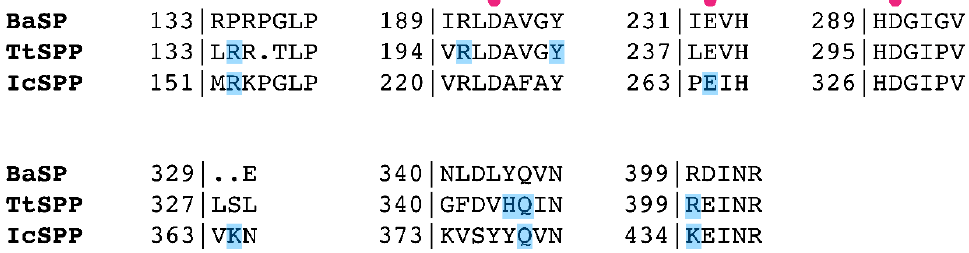
Figure 4. Partial multiple sequence alignment of BaSP, TtSPP, and IcSPP. Catalytic residues are indicated by a purple sphere. Residues suggested to be involved in binding of fructose 6-phosphate, according to automated docking, are highlighted in blue.